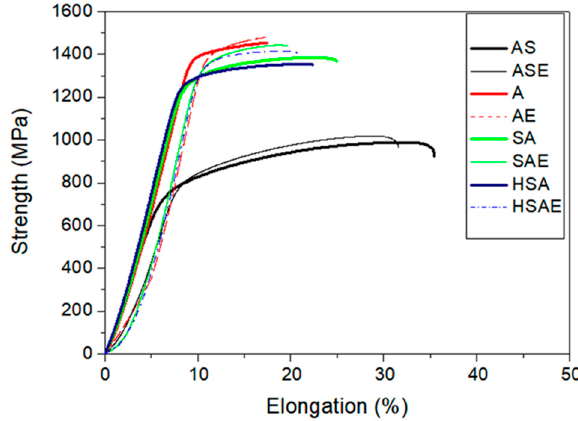
Figure 13. Stress–strain curve of specimen pre and post positive erosion.